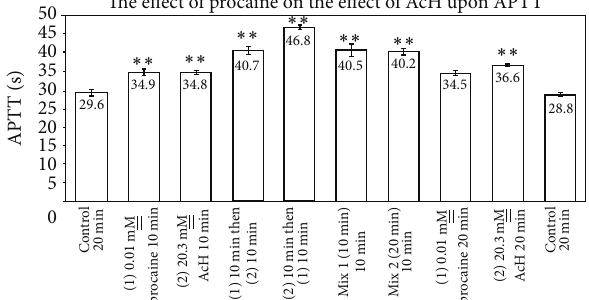
Figure 7: Effect of procaine and acetaldehyde upon APTT ( 𝑛 = 6 ; 𝑃 = 0.001